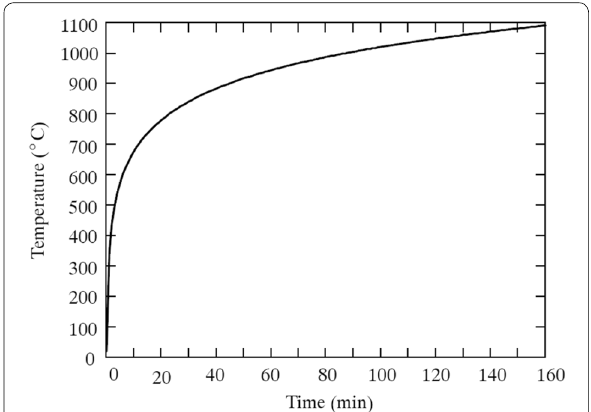
Fig. 3 ISO 834 time standard time–temperature curve.